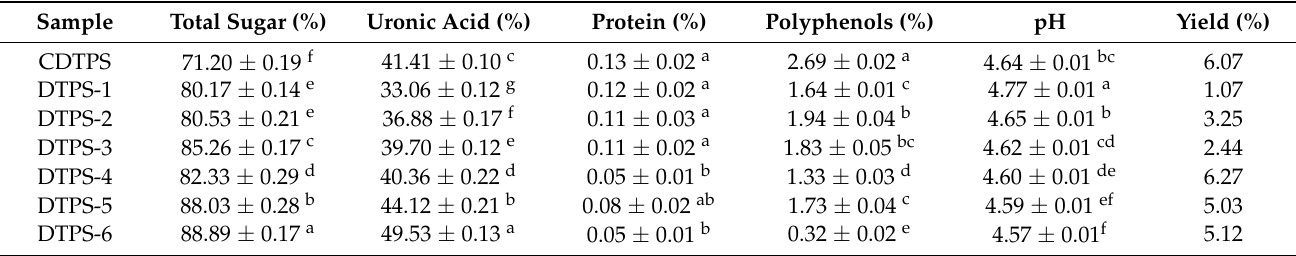
Figure 2. Elution curve ( a ), UV–Vis spectra ( b ), TTIR spectra ( c ), and XRD analysis ( d ) of the DTPSs. Table 1. Chemical composition of CDTPS and its eluted